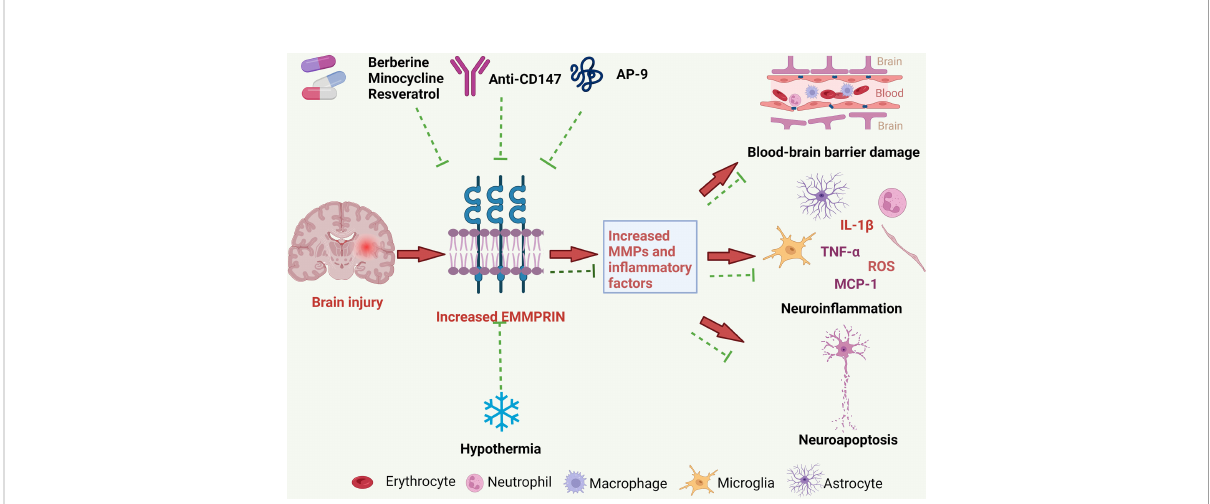
FIGURE 2 The pathological roles of EMMPRIN in ischemic and hemorrhagic strokes, and treatment strategies. EMMPRIN is elevated in endothelial cells, microglia and astrocytes following stroke. EMMPRIN induces the production of MMPs, and MMPs then degrade extracellular matrix proteins resulting in increased BBB permeability. EMMPRIN can also promote leukocyte extravasation through blood vessels, which further aggravates neuroin fl ammation. EMMPRIN may promote neuroapoptosis and exacerbate brain damage. Several promising therapies for ischemic and hemorrhagic strokes may target EMMPRIN, and these include medications and physical